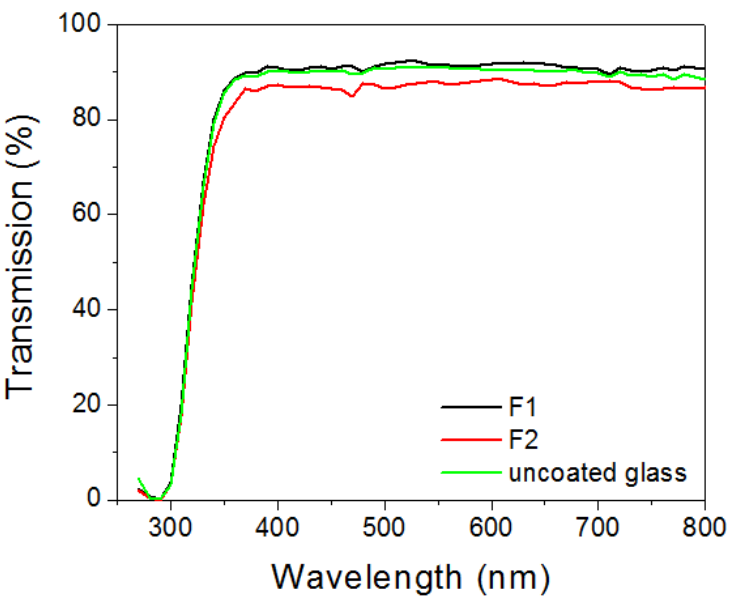
Figure 8. Transmittance spectra of the uncoated glass and the fluorinated hybrid coatings (TEOS/MTES/FS (F1) and TEOS/MTES/HDTMES/FS (F2)).